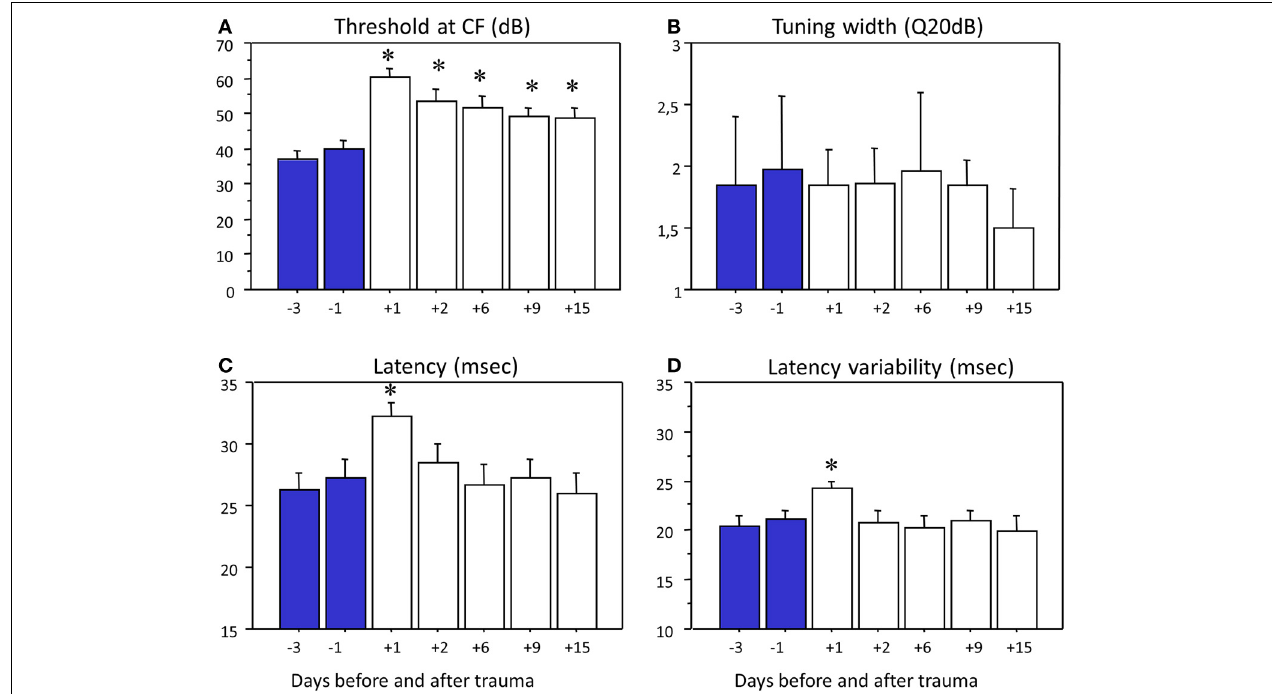
FIGURE 5 | Impact of hearing loss on the tuning curve parameters. The histograms display the averaged values of the threshold at CF (A) , tuning width (B) , latency (C) , and latency variability (D) across days before and after trauma (from 3 days before to 15 days after the trauma). Values before trauma are indicated in blue, whereas values after trauma are in white. The